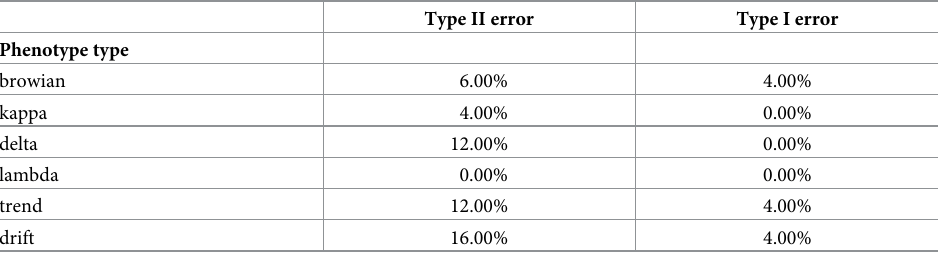
Table 1. Type I and Type II error